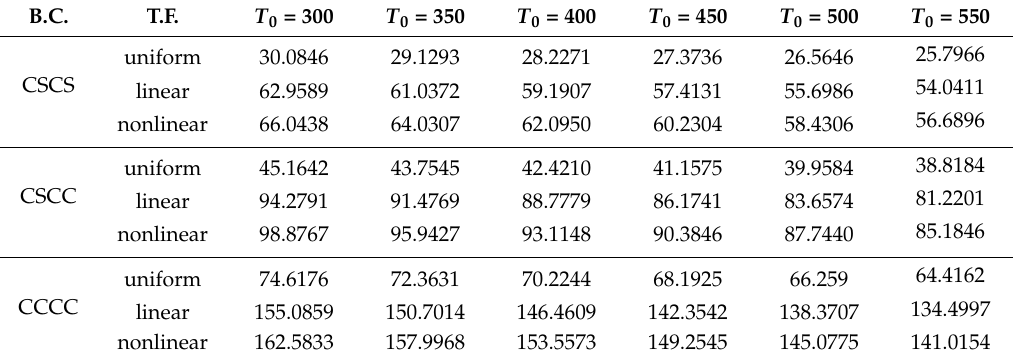
Table 12. Critical buckling temperature ∆ T cr of type-I FGM rectangular thin plate with different initial temperature T 0 ( a / h = 100, a / b = 2, n =